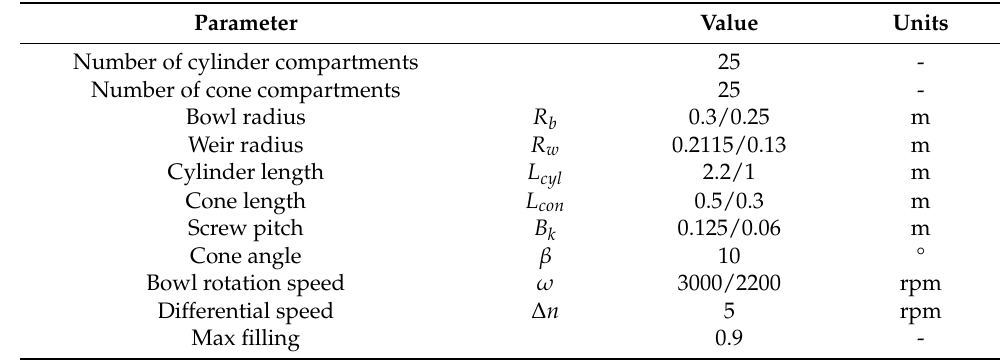
Table A5. Model parameters of the Centrifuge 1/Centrifuge 2 units used in the flowsheet simulations of the zeolite catalyst production